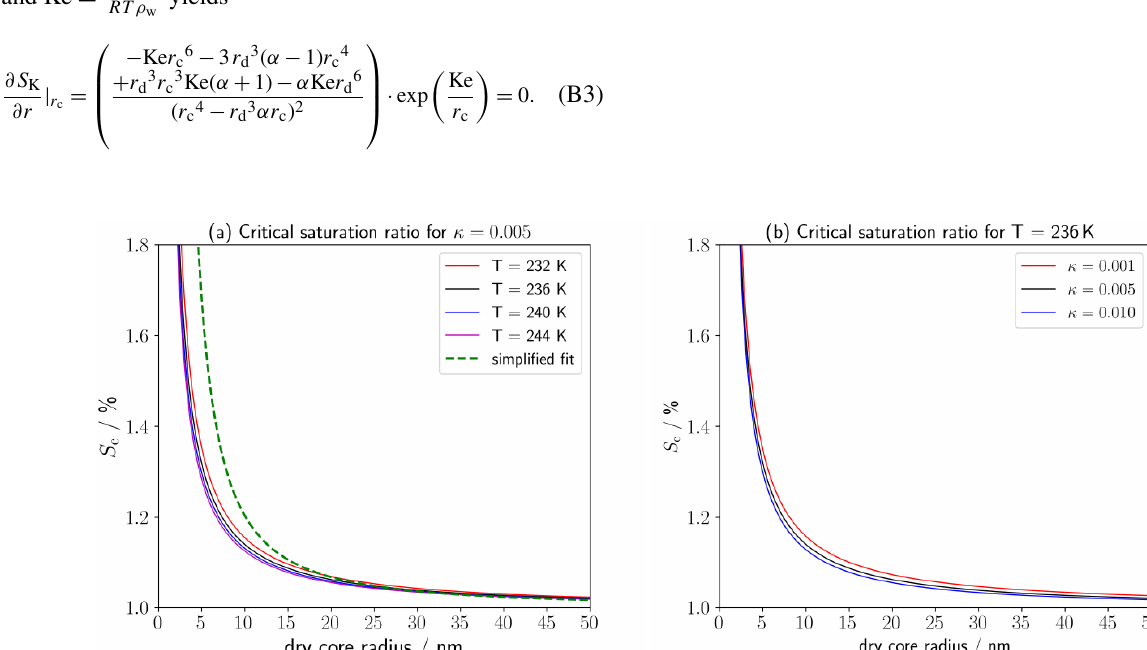
Figure B1. Critical saturation ratio ( S c ) for the activation of soot particles against dry core radius for different (a) plume temperatures and (b) the hygroscopicity parameter. The dashed line in (a) depicts the evolution of S c for the simplified Eq. (10) of Petters and Kreidenweis (2007) which is valid for κ ≥ 0 .